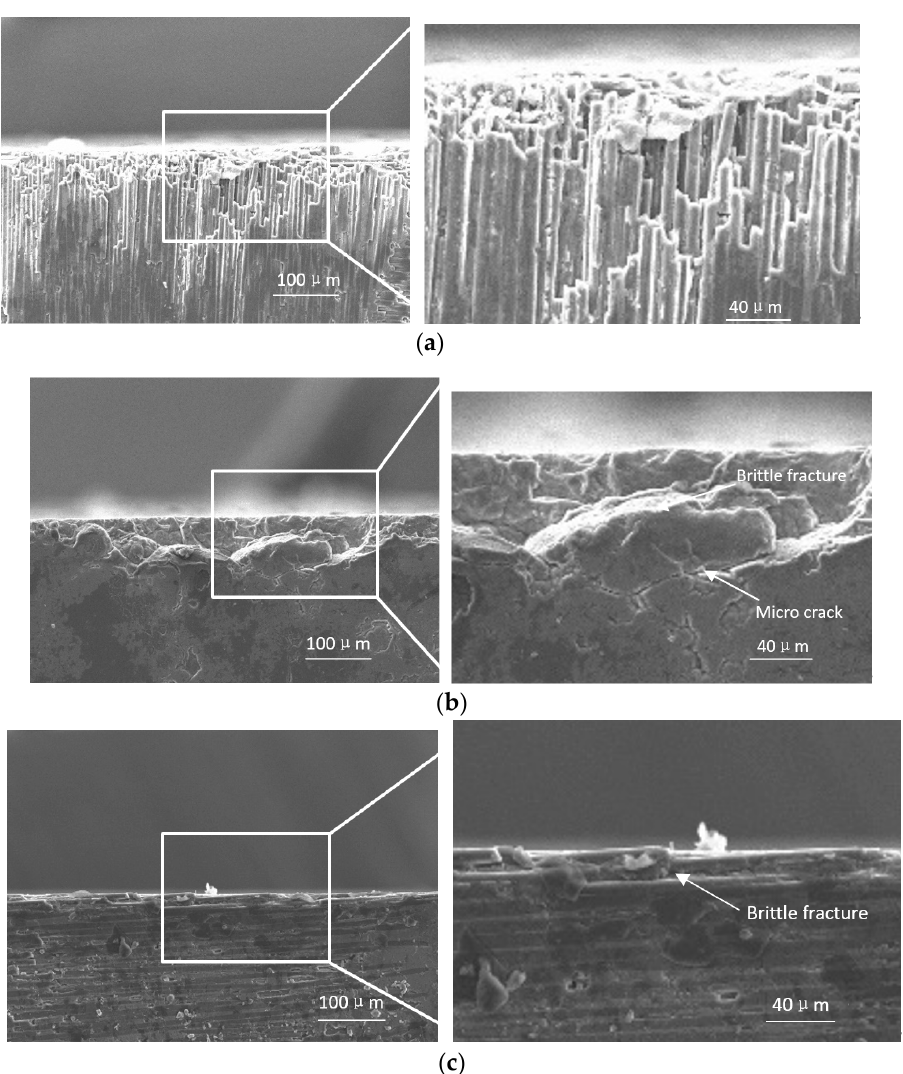
Figure 10. Subsurface damage types of the C/SiC composite after end face grinding. ( a ) 90° carbon fiber step brittle fracture. ( b ) The SiC matrix is a brittle fracture and spalling. ( c ) 0° carbon fiber edge brittle fracture.